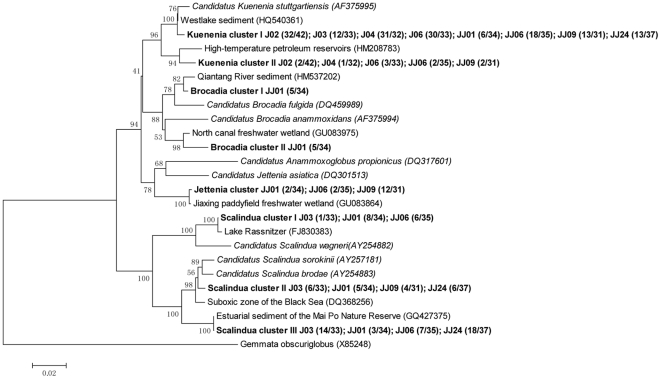
Phylogenetic tree showing the relationships between anammox bacteria-related 16S rRNA gene fragments in the clone libraries of samples from the Jiaojiang Estuary (bold) and known anammox bacteria (italics).Clone names are composed as follows: the sample name followed by the number of times a sequence was detected among all of the tested clones of a sample.